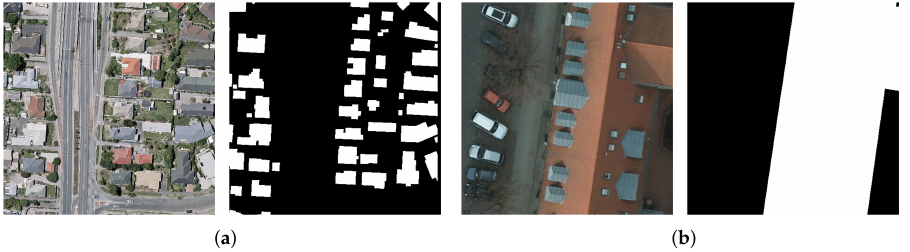
Figure 6. Examples of the images and corresponding labels for the two employed datasets. ( a ) and ( b ) represent the WHU dataset and Potsdam dataset, respectively. The white regions in the two reference maps stand for